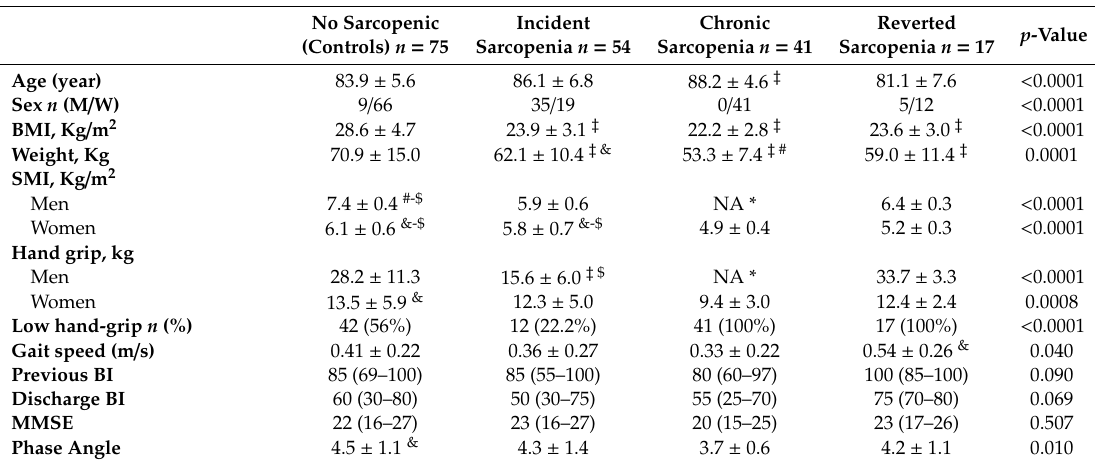
Figure 1. Flow chart of the study population and sarcopenia diagnosis at admission and at discharge. The assessment for sarcopenia was carried out at admission (the sample was divided as the no-sarcopenic and sarcopenic group) and before discharge (no-sarcopenic group at admission was divided as controls and incident sarcopenia, and the sarcopenic group at admission was divided as chronic sarcopenia and reverted sarcopenia). Total mortality was evaluated at 7 years of follow-up. Colored boxes indicate the time period (admission, discharge and follow-up period). Table 2. Admission differences between patients considering different sarcopenic and non-sarcopenic